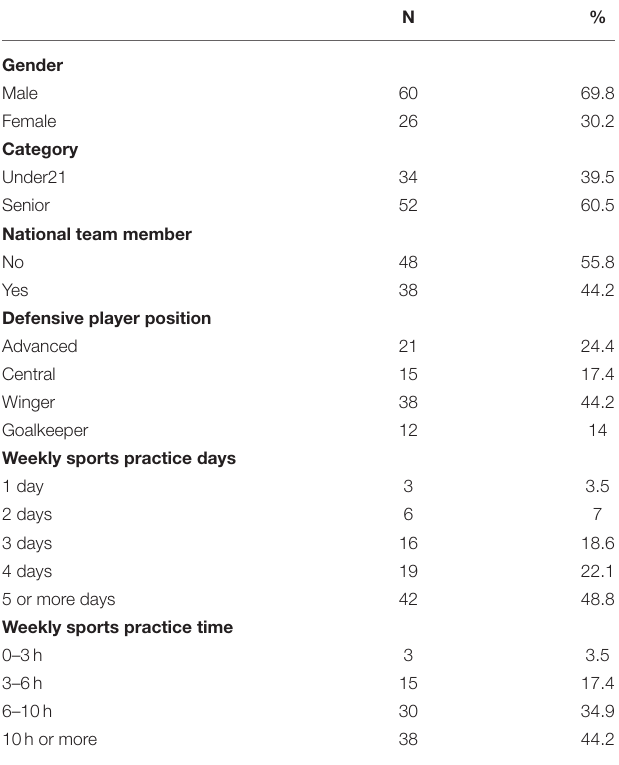
TABLE 1 | Sociodemographics statistics of the